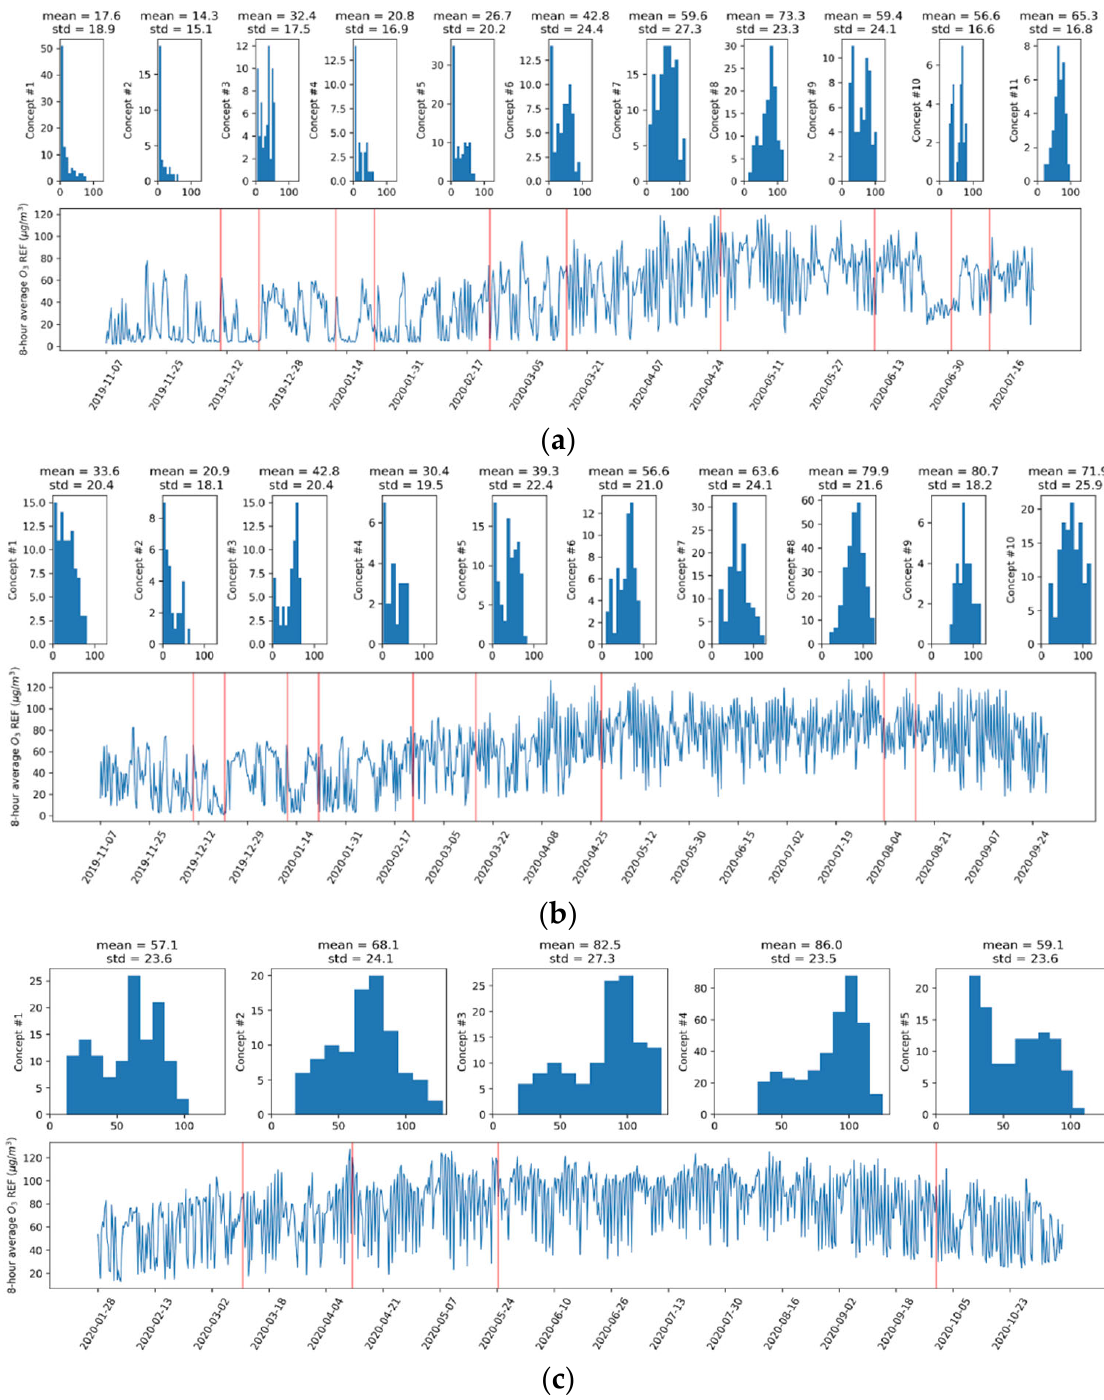
Figure 3. The detected concept drifts (red verticals) for: ( a ) Agia Sofia, ( b ) Kordelio and ( c ) Sindos for ozone time series.